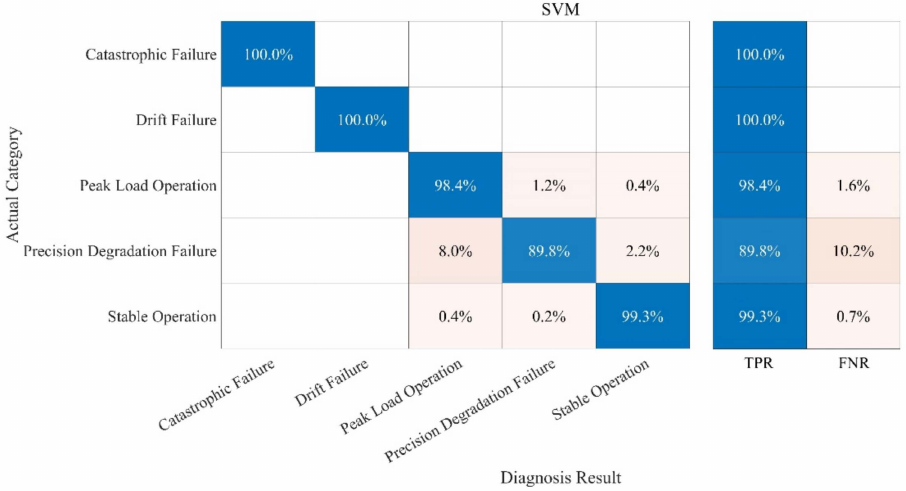
Figure 18. Fault Diagnosis Result of